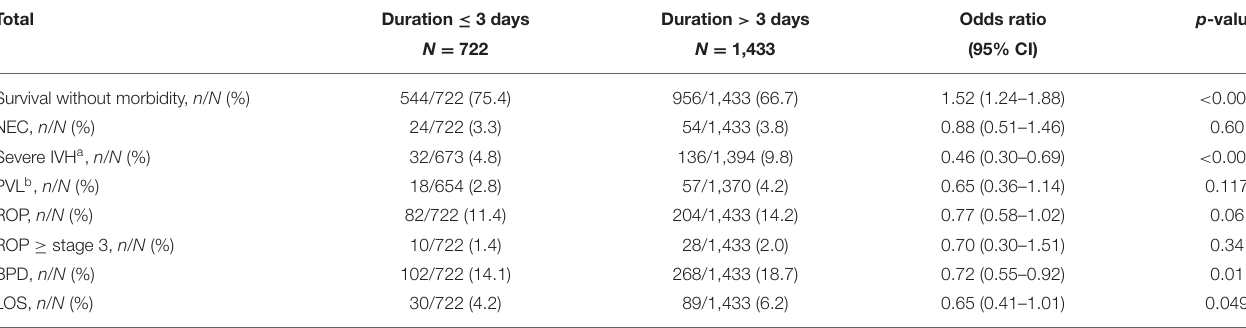
TABLE 3 | Outcomes and cardiovascular pharmacological support duration among